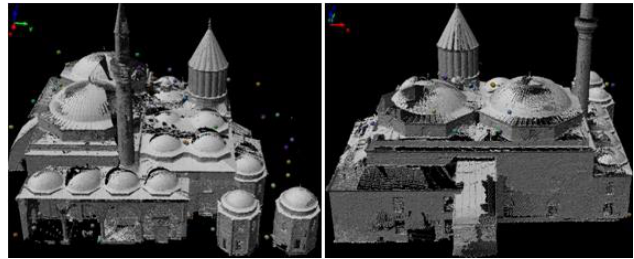
Figure 6. The outside 3-D point cloud model of the Mevlana Museum. The images are from west ( left ) and north ( right ) sides.